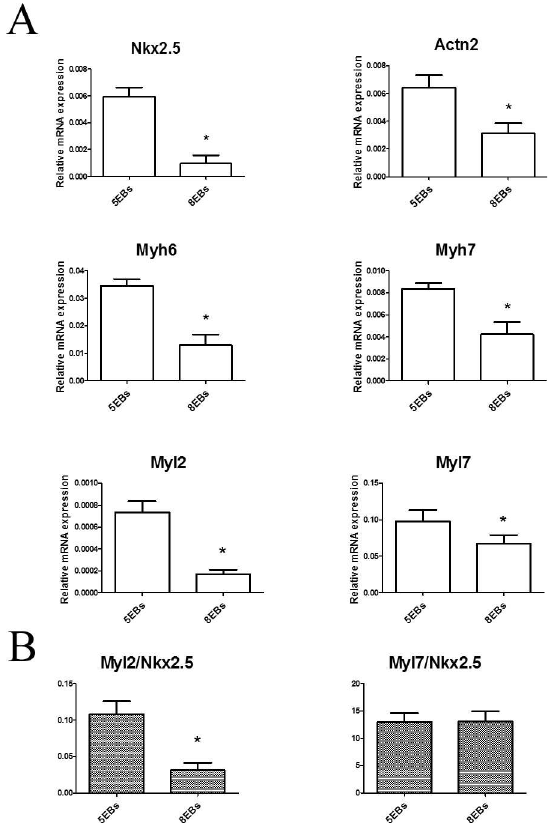
Fig 2. Gene expressions of transcriptionalfactor Nkx2.5, Actn2, Myh6, Myh7, Myl2 and Myl7, recognized as markers of cardiomyocyte differentiation in mouse ES R1 cells that were differentiatedfor 20 days in vitro